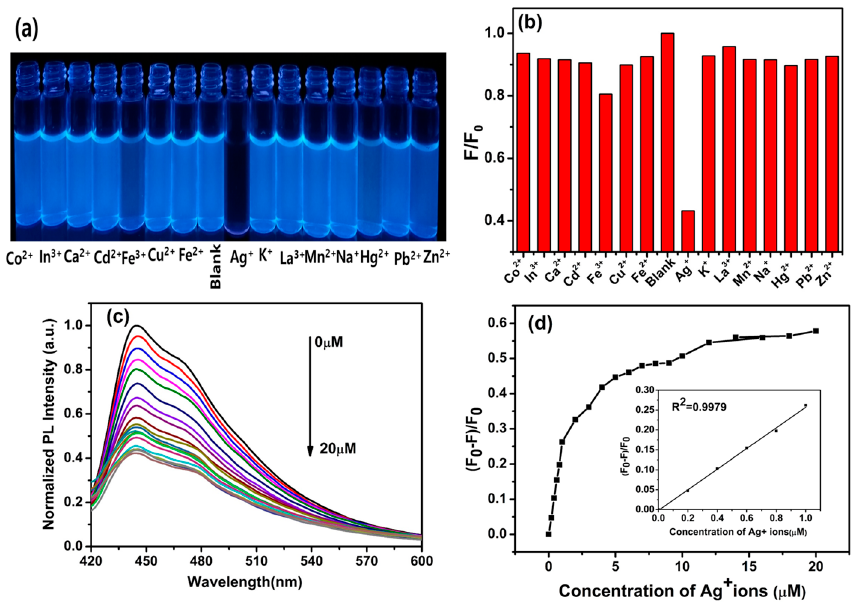
Figure 5. ( a ) Photographs of the aqueous SCNPNS containing 20 µ M of various metal ions under UV light (excited at 365 nm). ( b ) The fluorescence intensity, F, of SCNPNS with various metal ions (20 µ M) relative to that of the pure water, F 0 . ( c ) Fluorescence emission spectra of the aqueous SCNPNS with the increase of Ag + from 0 to 20 µ M, under excitation at 350 nm. ( d ) The dependence of fluorescence intensity on the concentration of Ag + ions in the range of 0 to 20 µ M, and the inset shows the linear relationship between the fluorescence intensity and Ag +